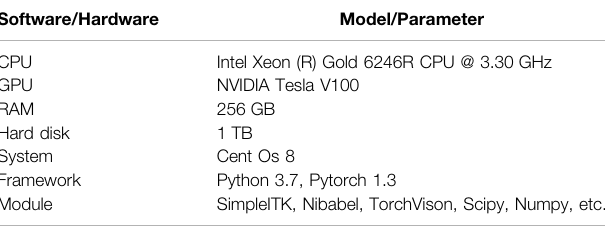
TABLE 1 | Summary of the experimental environment.